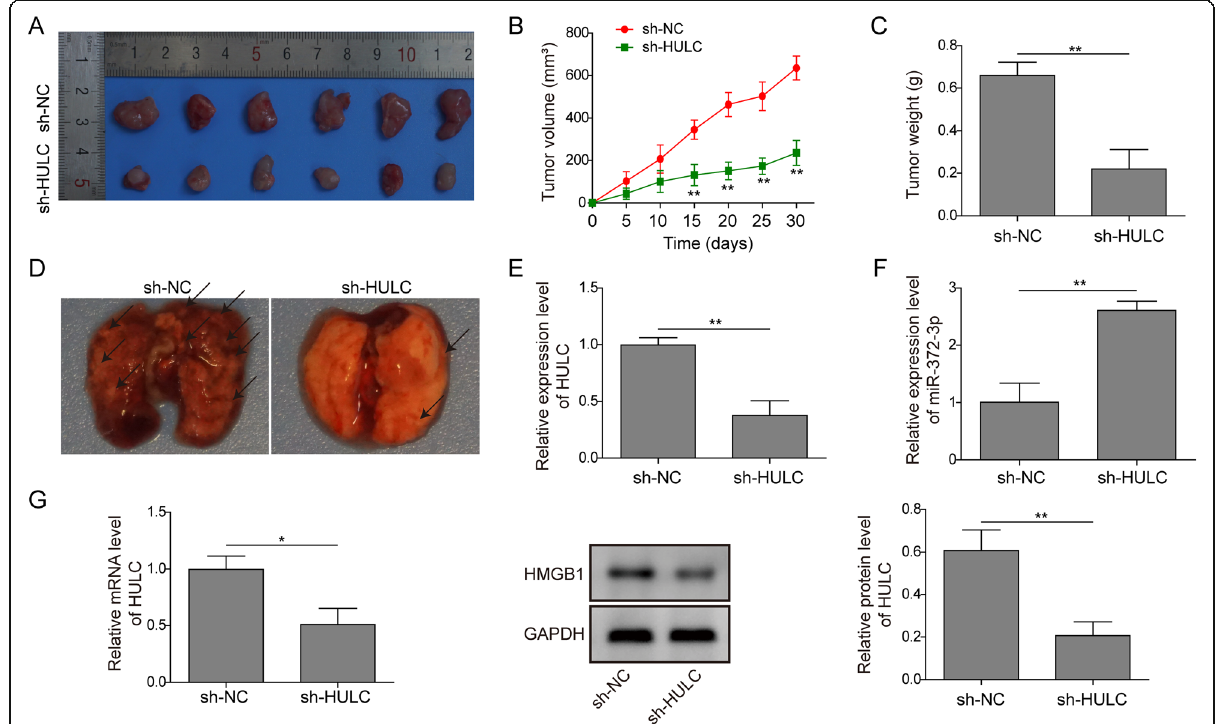
Fig. 7 In vivo validation: HULC knockdown inhibited osteosarcoma tumour growth and metastasis. Images of tumours from the nude mouse model (A); statistical analysis of tumour volume (B) and weight (C); images of lung tissues from the nude mouse model (D); qRT-PCR or western blot was performed to evaluate the relative mRNA or protein expression levels of HULC (E), miR-372-3p (F) and HMGB1 (G). Data are shown as the mean ± SD. * p < 0.05, ** p <